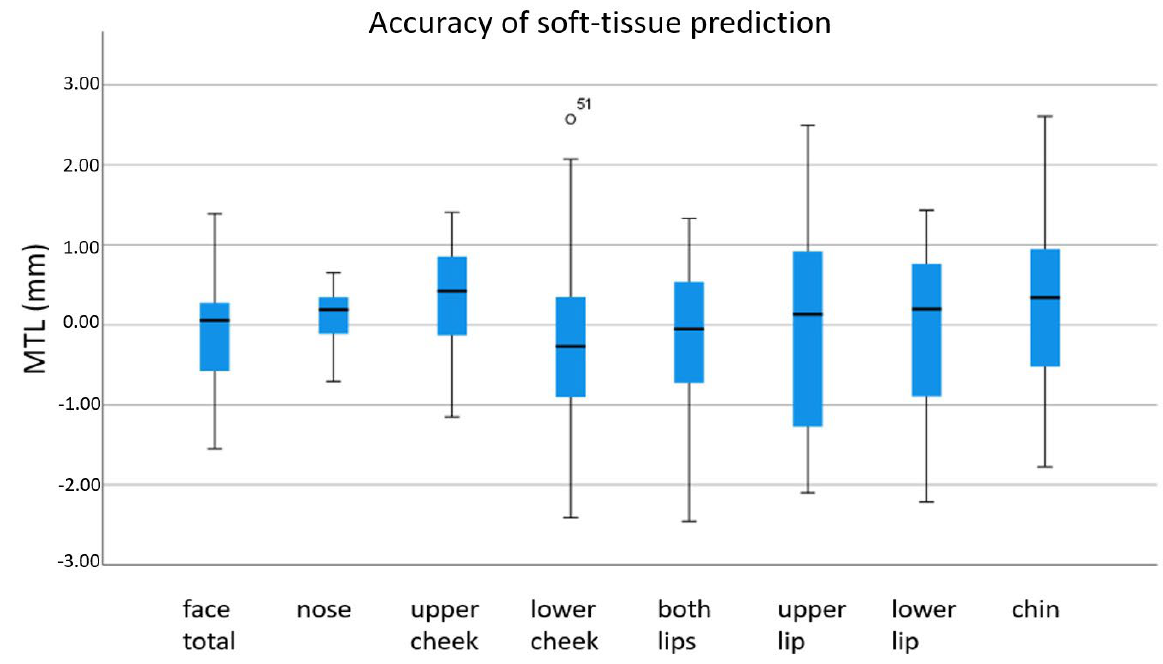
Figure 4. Mean absolute discrepancy between postoperative 3D scan and preoperative soft-tissue simulation. ◦ : moderate outlier: 1.5–3.0 × IQR (interquartile range).